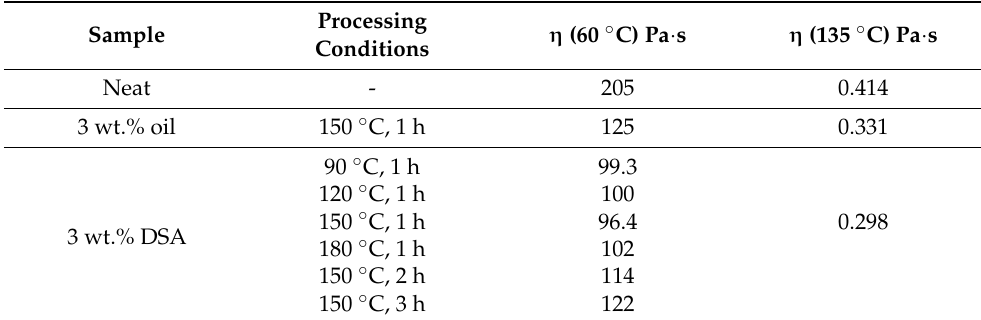
Table 2. Zero-shear limiting viscosities obtained from steady-state flow tests, at 60 ◦ C; and Brookfield viscosities, at 135 ◦ C, for unaged neat and modified bitumens.